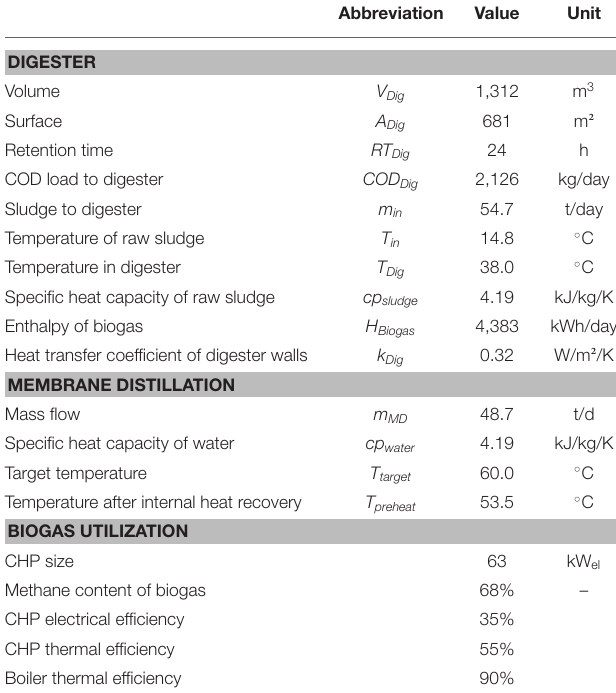
TABLE 2 | Relevant parameters for energetic